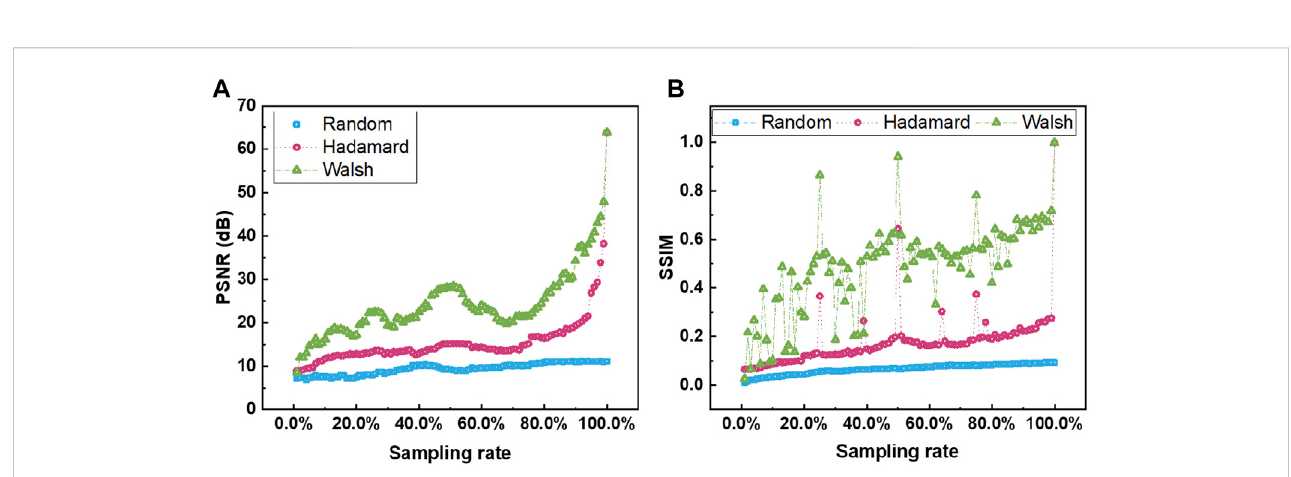
FIGURE 4 (A) PSNR indicator and (B) SSIM indicator vs sampling rates of laser GI based on random, Hadamard, and Walsh speckle patterns in the noiseless